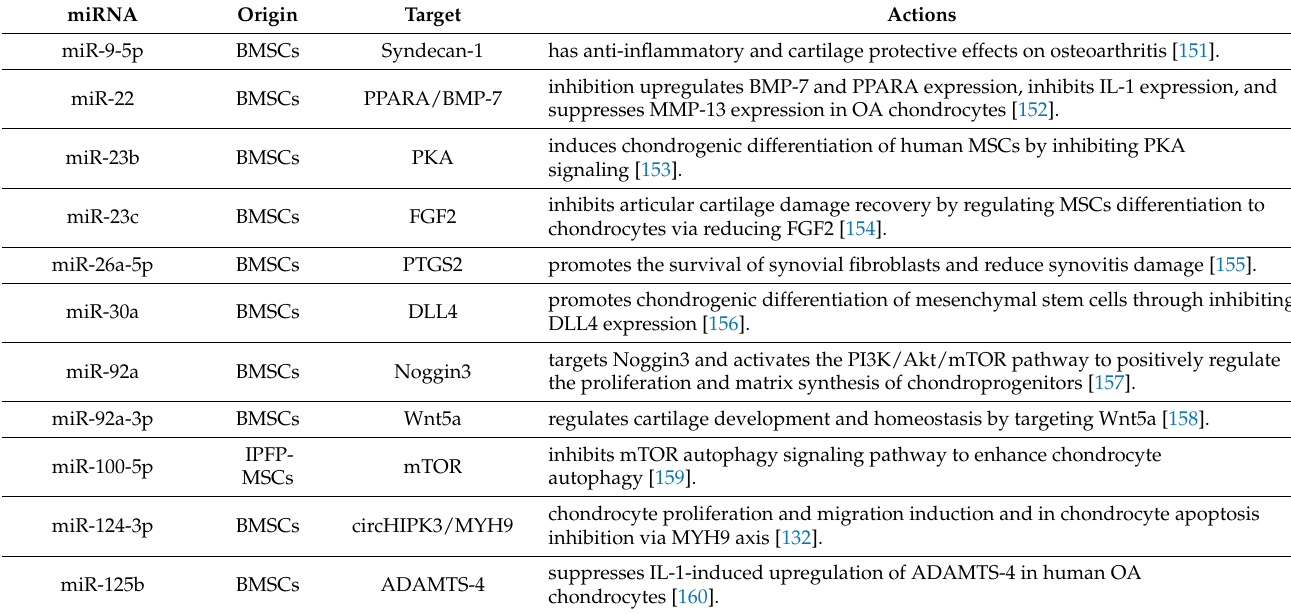
Table 1. Cartilage regeneration-related miRNAs from MSC-derived